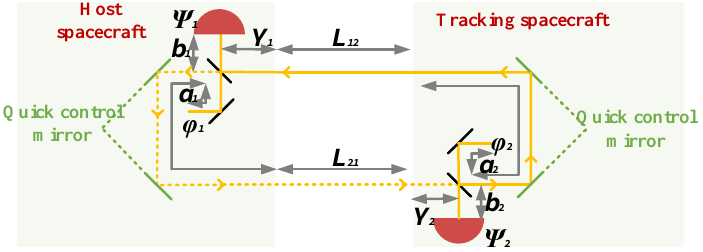
Figure 19. Schematic diagram of the GRACE Follow-on laser measurement system.